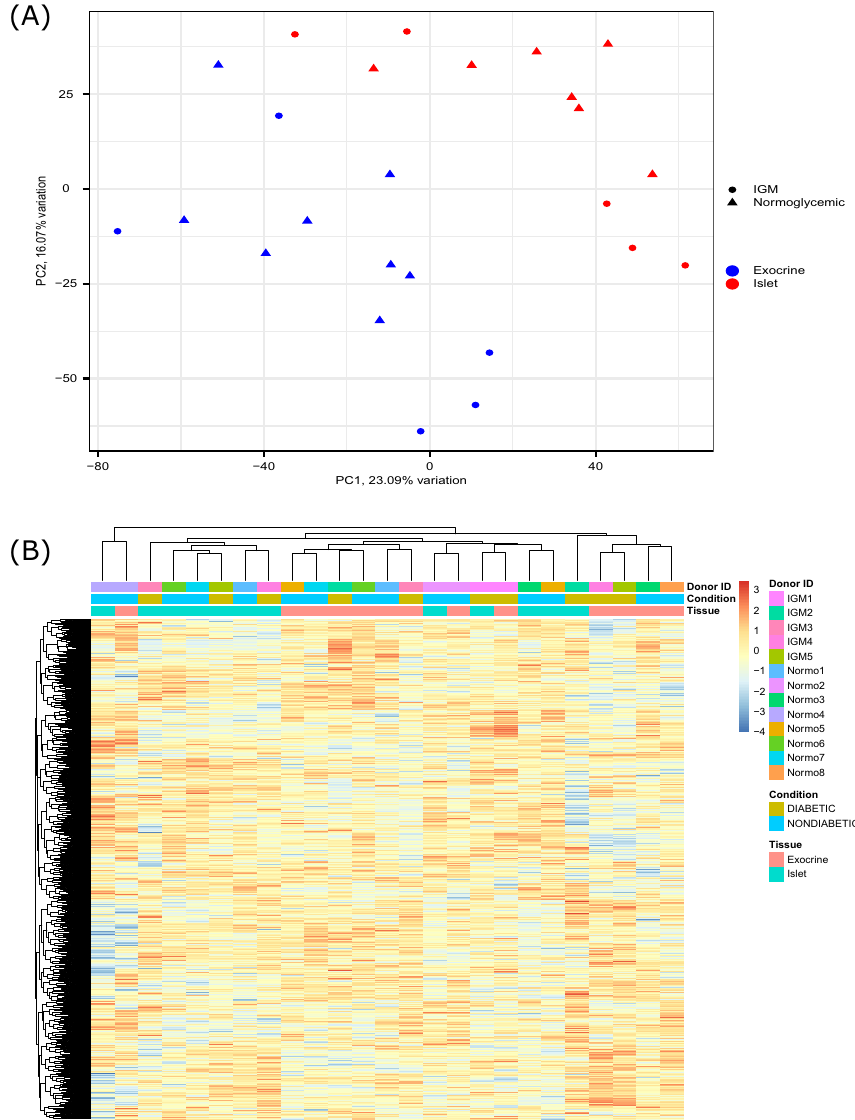
Figure 2. ( A ) Principal component analysis showing sample variation in two-dimensional principal component space for the sorted islet and exocrine endothelial cell samples. PC1 accounts for 23.09% of the total variation and PC2 16.07% of the total variation. Circles indicate samples from IGM (Impaired Glucose Metabolism) donors, triangles indicate samples from normoglycemic donors. Red indicates islet MVEC samples, blue indicates exocrine MVEC samples. n = 12 (islets) and n = 13 (exocrine). ( B ) Heatmap with hierarchical clustering of genes and samples using the 1000 genes with the most variance. Color intensity indicates expression level, given as z-score of CPM- TMM- normalized counts. The colored bars on top indicates donor ID, condition (glycemic status) and tissue of origin respectively. A trend towards clustering by tissue of origin is evident. When samples from exocrine and islet cluster together, they originate from the same donor. n = 12 (islets) and 13